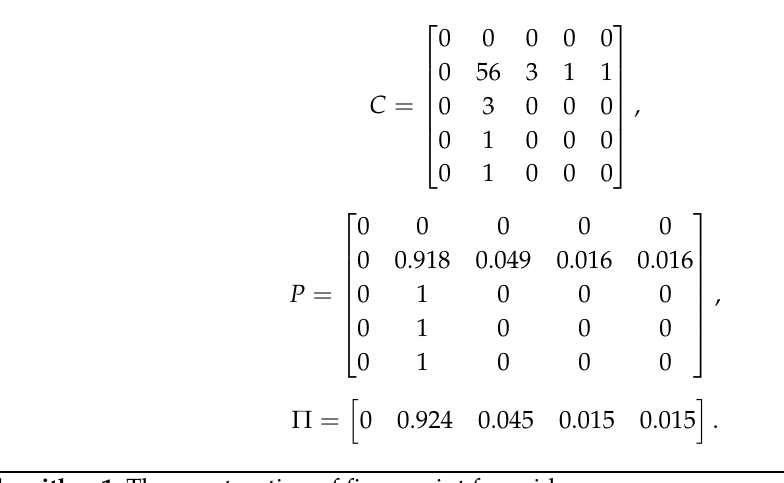
Algorithm 1: The construction of fingerprint for grid g